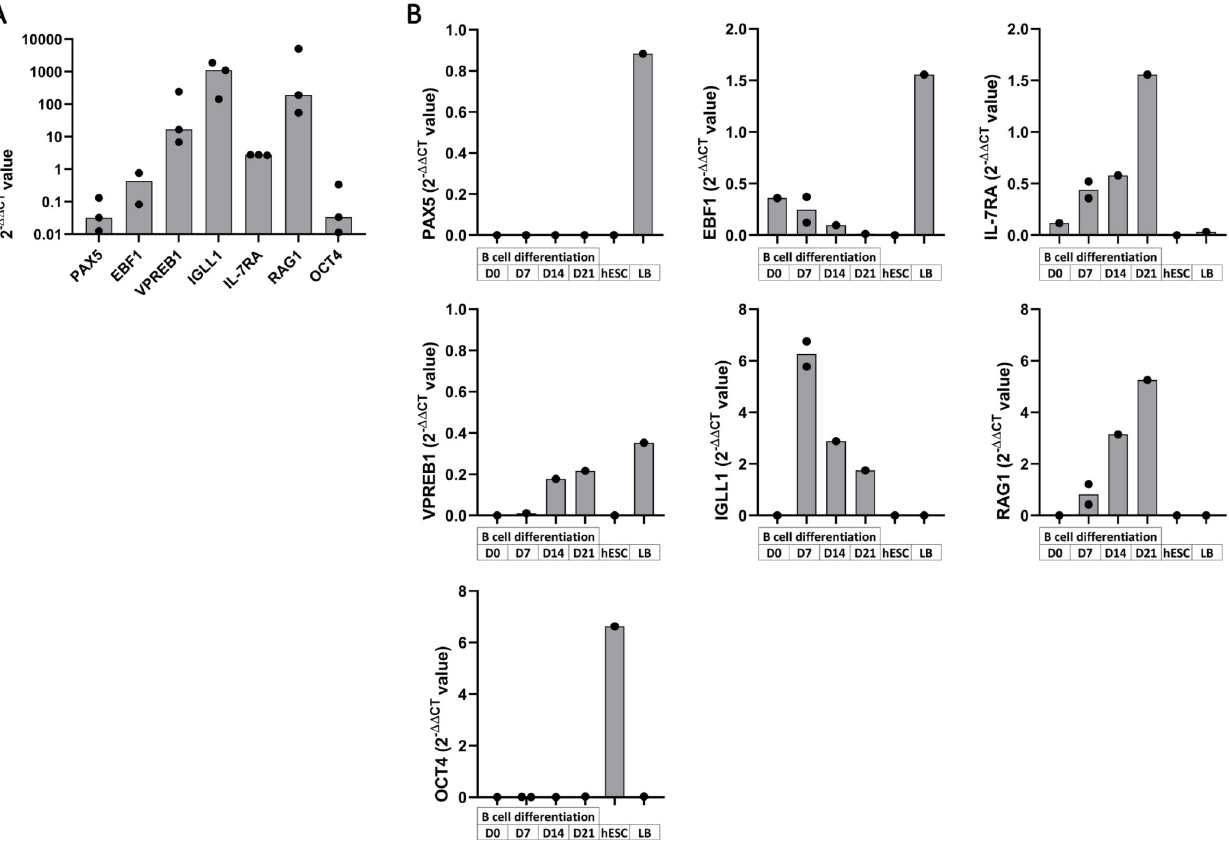
Fig 5. Gene expression at different time point of B cell differentiation. Gene expression analysis by Taqman expression assay of PAX5 , EBF1 , VPREB1 , IL-7RA , IGLL1 , RAG1 and OCT4 were performed on total cells at different time point during B cell differentiation. Histograms of 2 -DDCT value display gene expression analysis of cells (A) at Day 21 of B cell differentiation from UCB CD34 + cells (n = 2 to 3 independent experiments) and (B) at Day 0 (D0), 7, 14 and 21 of B cell differentiation from hESC-derived CD34 + with undifferentiated hESC and tonsil B cells (LB) as controls (n = 1 to 2 independent experiments).